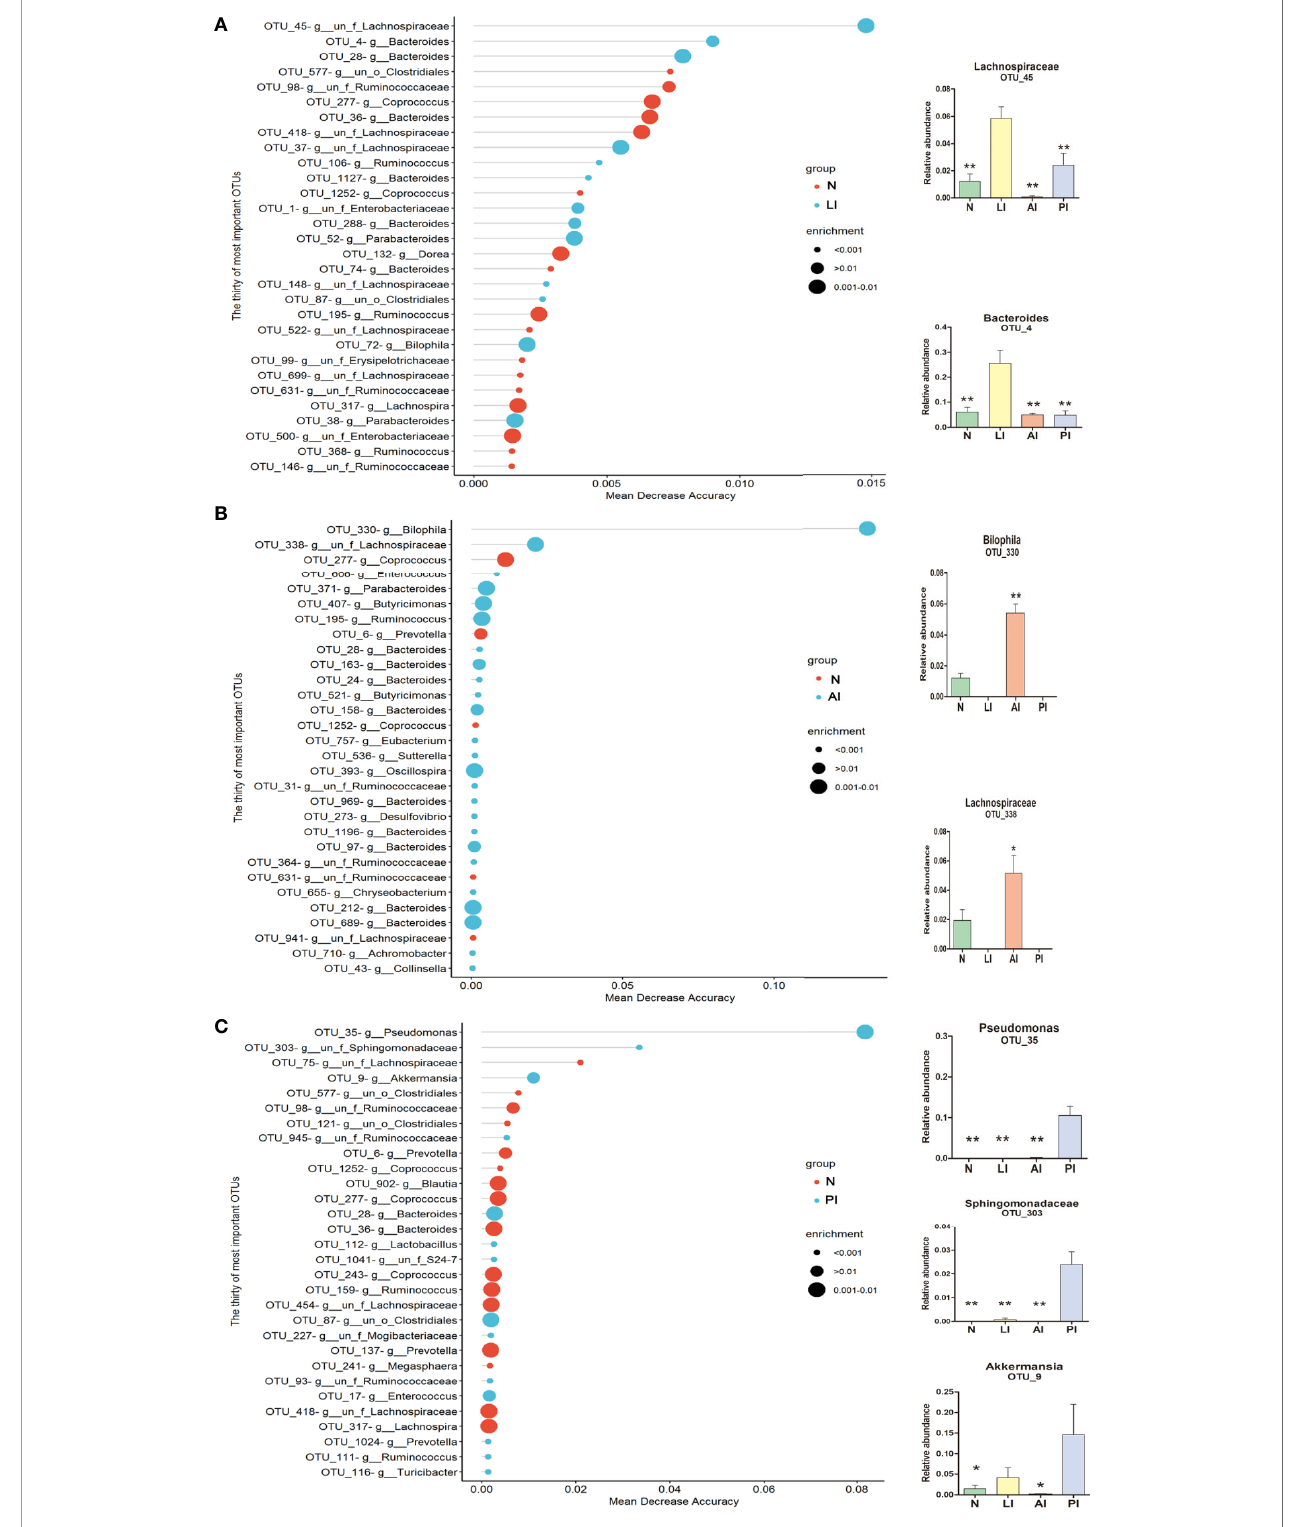
FIGURE 7 | OTU-based markers of ischemic stroke identi fi ed by the Random Forest model. (A) lacunar infarction. **p < 0.01 compared with the LI group. (B) non- lacunar acute ischemic infarction. *p < 0.05 and **p < 0.01 compared with the AI group. (C) post-ischemic stroke. *p < 0.05 and **p < 0.01 compared with the PI group.